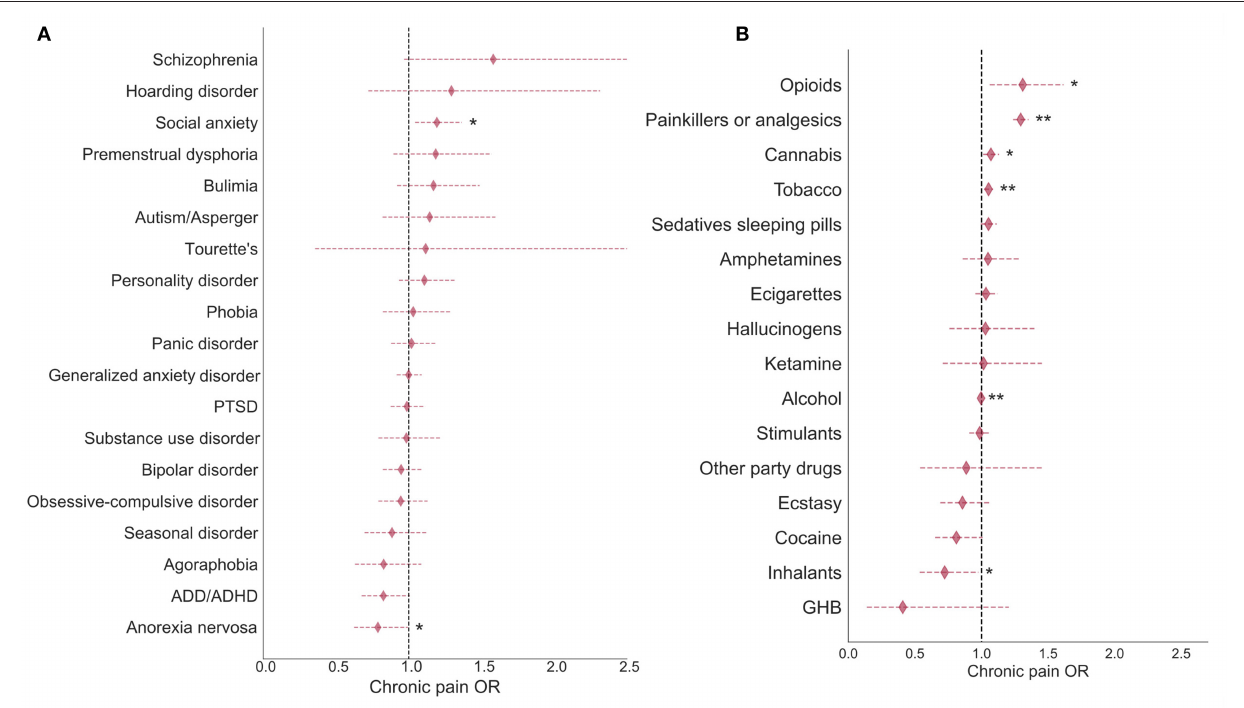
FIGURE 2 | Comorbidities and substance use associations with chronic pain in AGDS cohort. Forest plots depict the chronic pain odds ratios (ORs) for (A) comorbid disorders and (B) recent substance use during the past 3 months. Chronic pain was significantly associated with decreased use of alcohol, increased use of tobacco, and painkiller misuse (e.g., opioids). Diamonds represent ORs and horizontal lines depict 95% CI. ORs were estimated from a multivariate logistic regression accounting for all relevant covariates (see Methods). * p < 0.05; ** p < 0.05 after Bonferroni correction for multiple testing (AGDS data only).